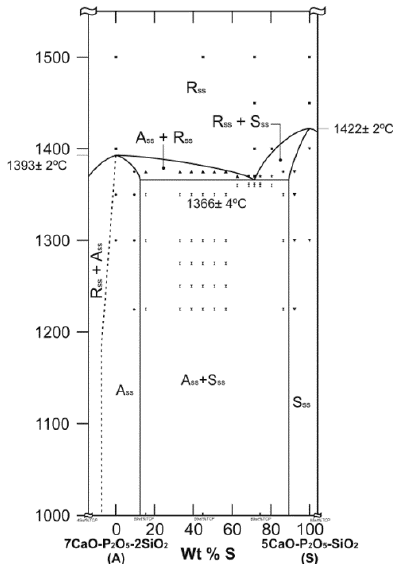
Figure 3. Redrawn of the subsystem Nurse’s A-phase-silicocarnotite within the binary system C 2 S-TCP. (S ss : silicocarnotite ss ; Nurse’s A: Nurse’s A-phase ss ; R ss : ( α -C 2 S- α ´TCP) ss ).